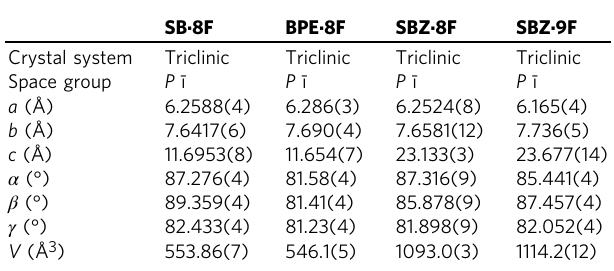
Table 1 Crystallographic parameters for cocrystals that undergo